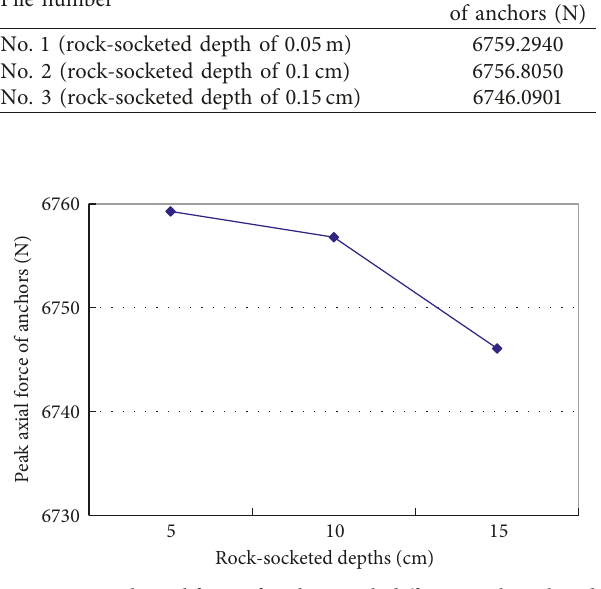
Figure 17: Peak axial force of anchors with different rock-socketed depth depths.